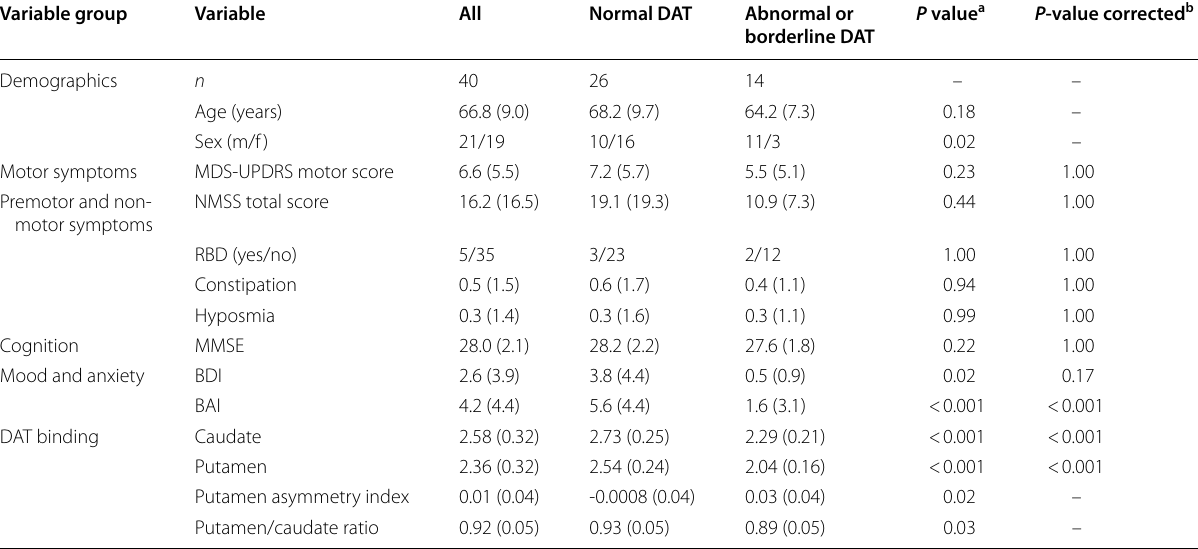
Values are means (SD) or n a Mann-Whitney U -test, independent-samples t -test or Fisher’s exact test b Bonferroni correction to adjust for multiple comparisons for two DAT binding regions and for eight symptom scales and questionnaires. Numbers of missing values: BAI =